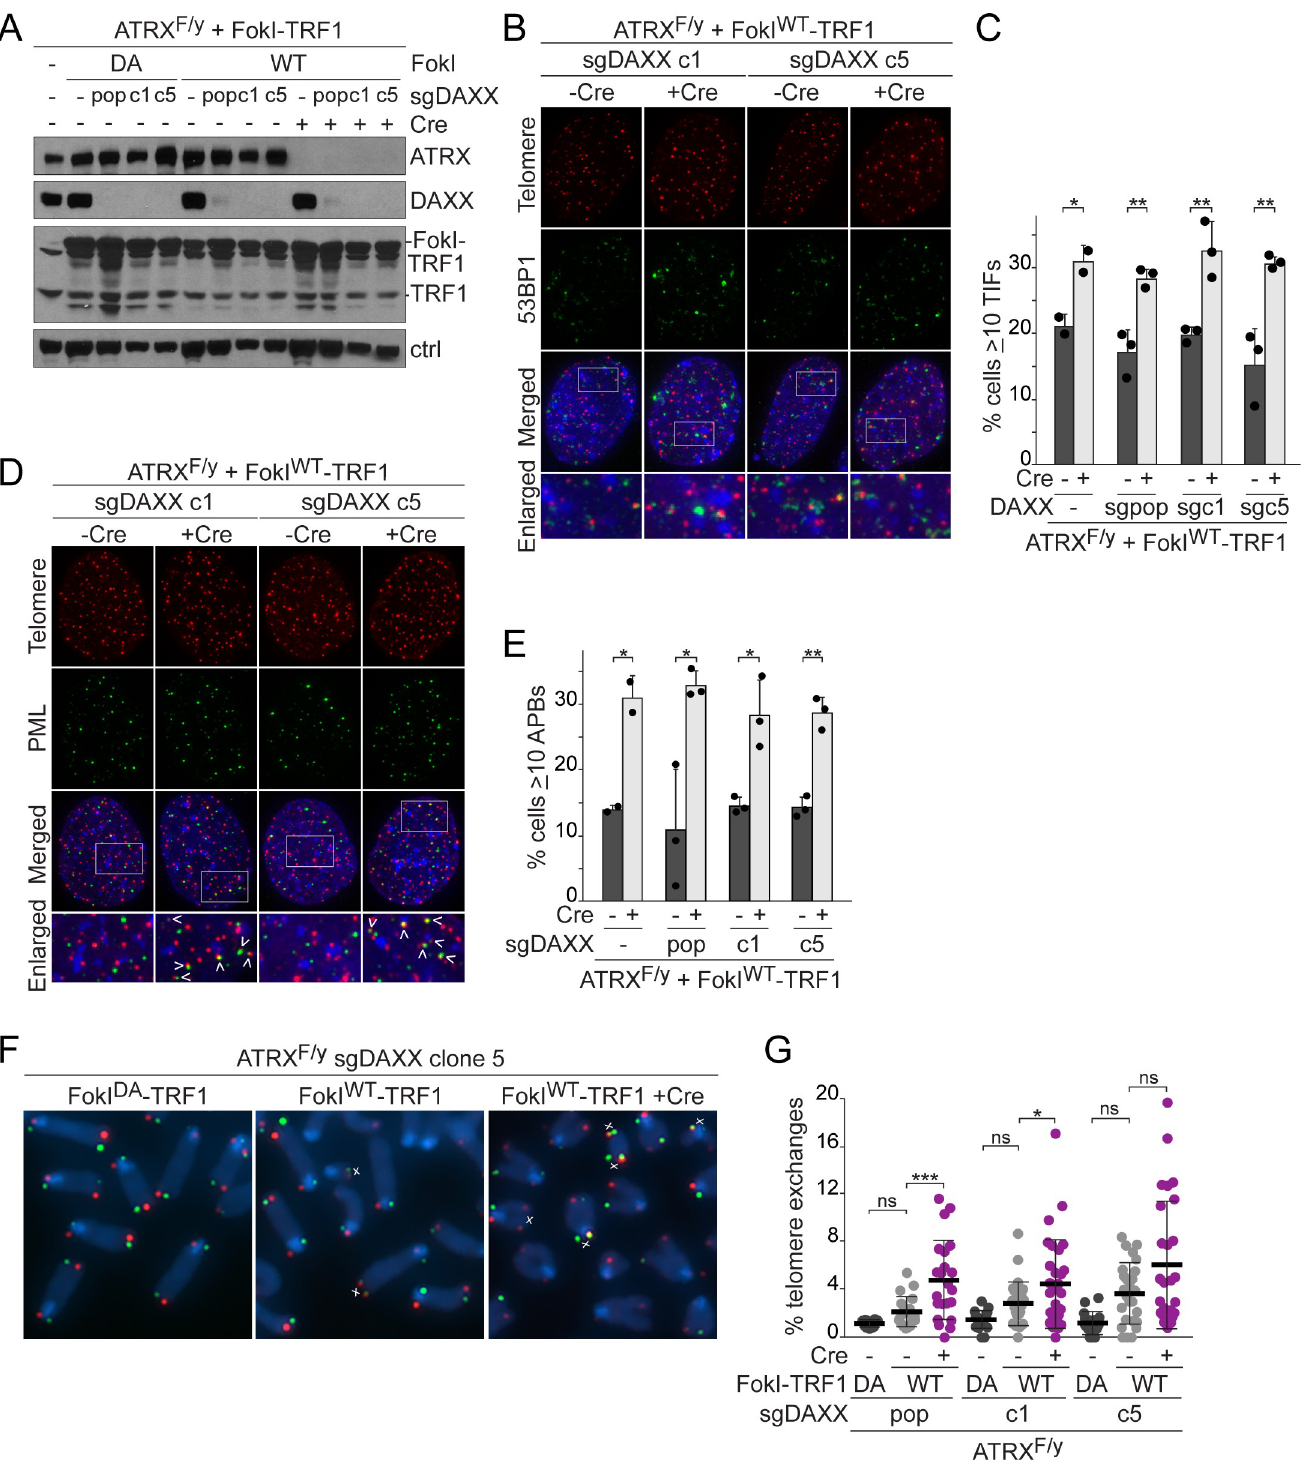
Fig 5. Deletion of DAXX does not alter telomeric DSB repair. (A) Immunoblots showing FokI-TRF1 expression (6 days) in control and CRISPR/Cas9-targeted DAXX KO ATRX F/y MEFs treated with Cre (4 days). pop, a DAXX-targeted population of cells; c1/c5, DAXX KO clones; Ctrl, nonspecific band used as a loading control. (B) Detection of TIFs in 2 DAXX KO ATRX F/y clones expressing FokI WT -TRF1 by IF-FISH as in Fig 1C. (C) Quantification of the TIF response in FokI WT - TRF1–expressing cells, as assayed in (B). Bars: means and SDs from 3 experiments for DAXX KO MEFs (means and SEMs from 2 experiments for control MEFs) of > 100 cells each. (D) APBs in 2 DAXX KO ATRX F/y clones expressing FokI WT -TRF1 detected by IF-FISH as in Fig 1E. (E) Quantification of the percentage of cells